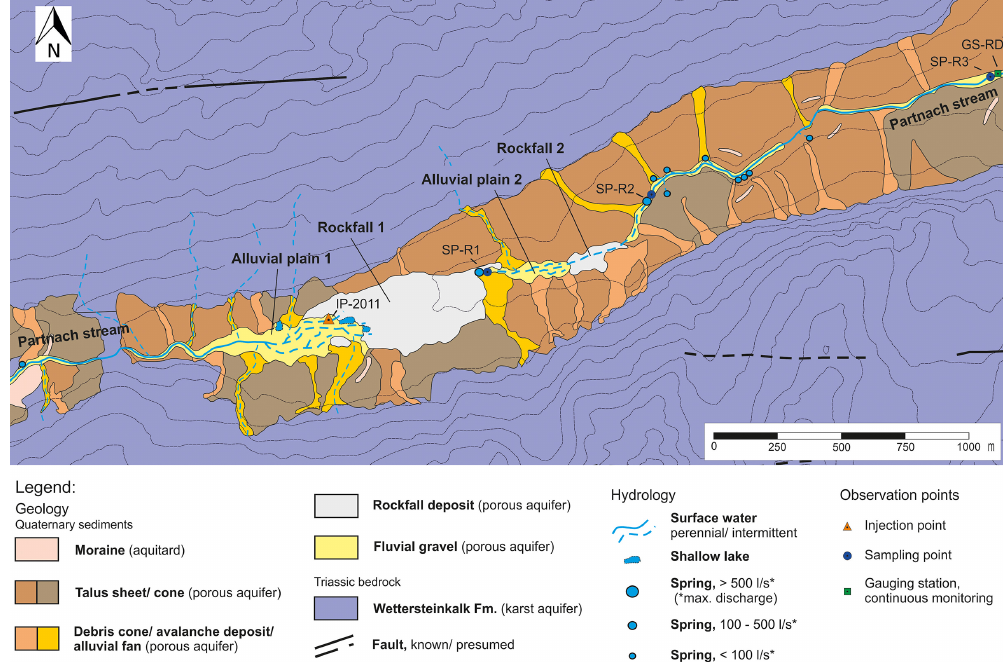
Figure 2. Hydrogeologic map of the Reintal covered with postglacial sediments, including alluvial plains and rockfall deposits (Schrott et al., 2006). The occurrence and location of surface streams and springs depends on hydrologic conditions. A longitudinal profile is provided in Fig. 4.